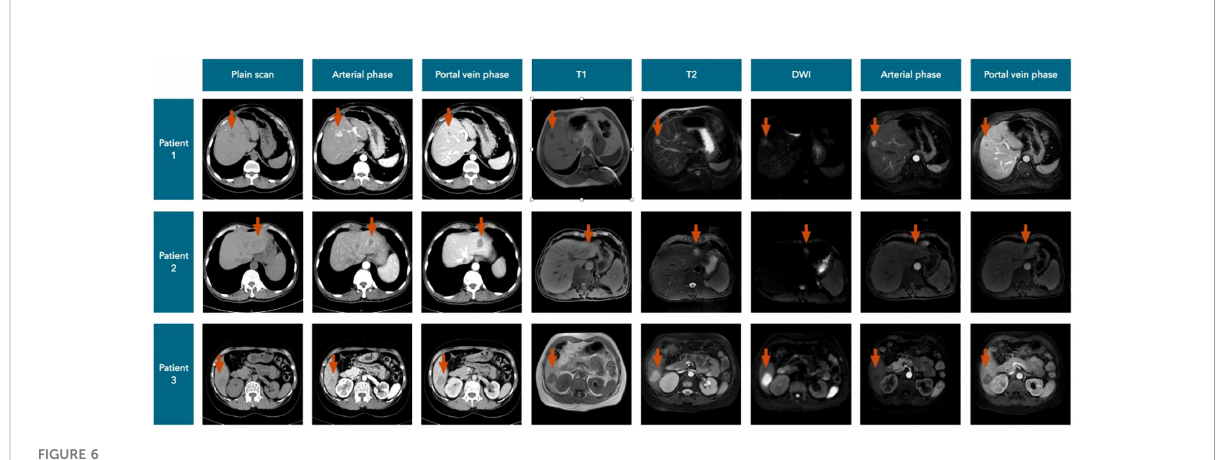
FIGURE 6 CT and MRI images of three